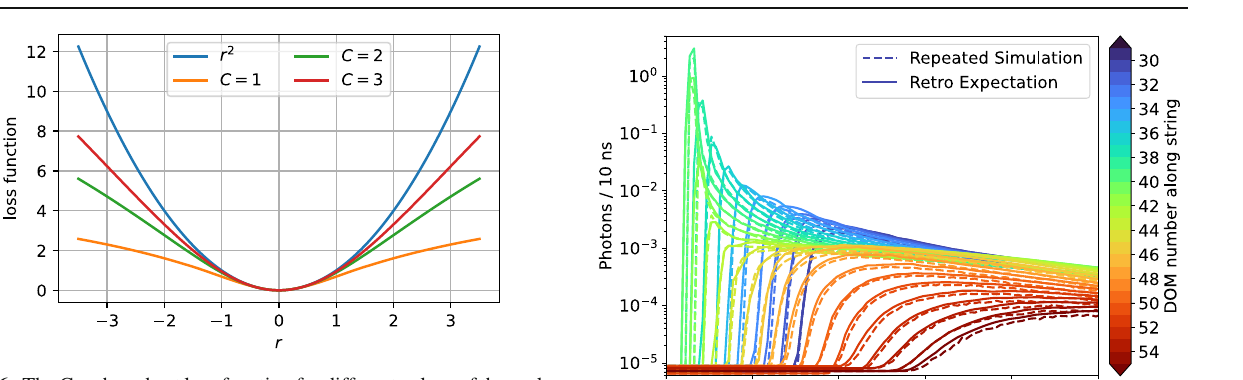
Fig. 6 The Cauchy robust loss function for different values of the scal- ing parameter, C . In a χ 2 fit, the residual is the difference between the model and the observation in units of standard deviations, r = x − μ σ